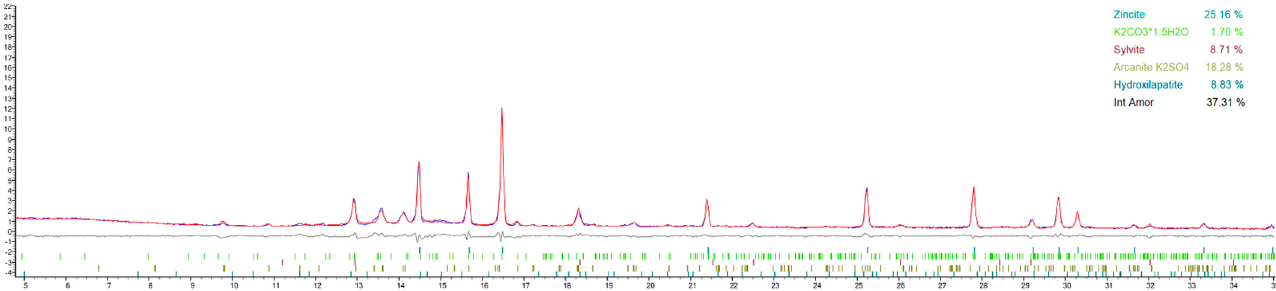
Figure 1. Results of X-ray diffraction of biomass bottom ash (BBA).